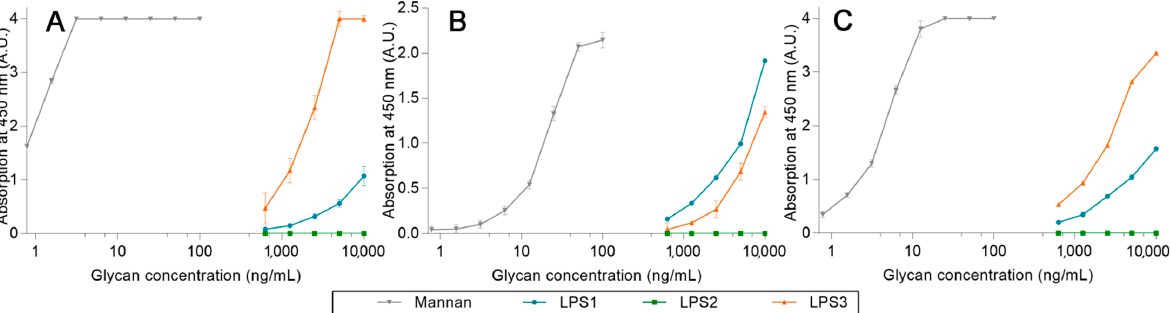
Figure 15. LPS avidity array assays using fixed hMBL ( A ), hSP-D ( B ), and pSP-D ( C ). Lectins fixed on magnetic beads are mixed in LPS solutions for 20 min at room temperature. After three washing steps, beads are placed in a solution of hMBL-HRP for 20 min at room temperature. Avidity determination occurs after the oxidation of the TMB solution by the washed beads and absorbance reading at 450 nm.